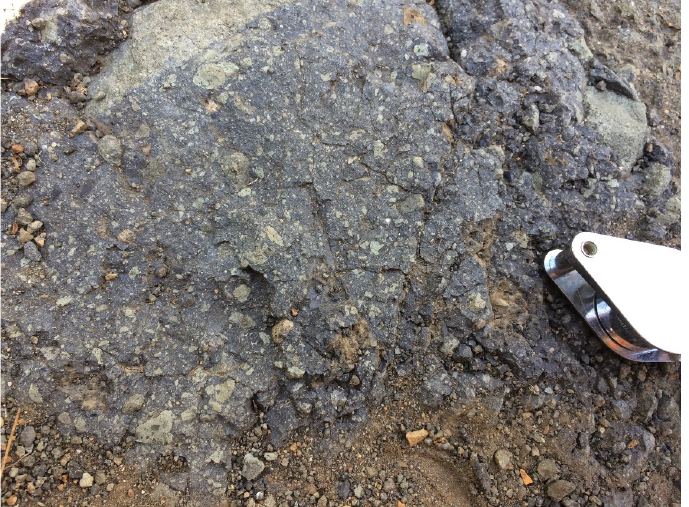
Figure 4. Accretionary lapilli in the northern face of Hornsby Quarry: an important feature of diatremes at the microscale. Hand lens has a short diameter of 2 cm.